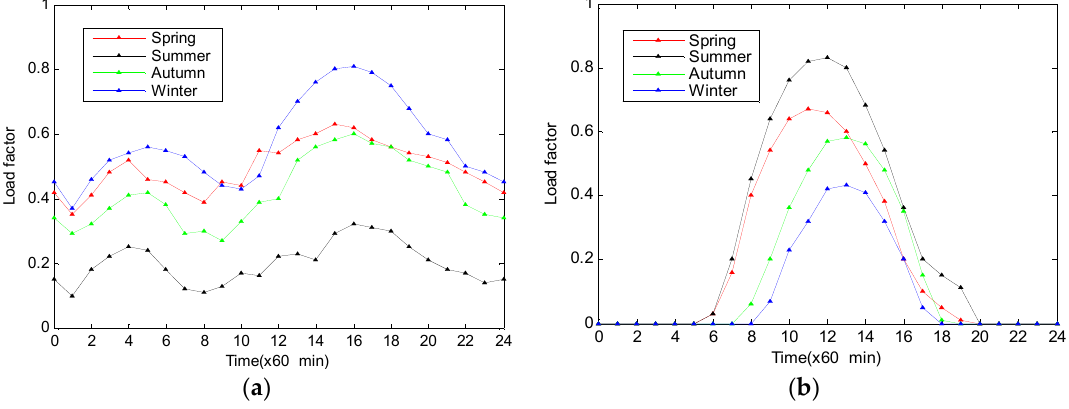
Figure 2. The typical daily curves of the WT output and PV output with four seasons. ( a ) The typical daily curves of WT output; ( b ) The typical daily curves of PV output.